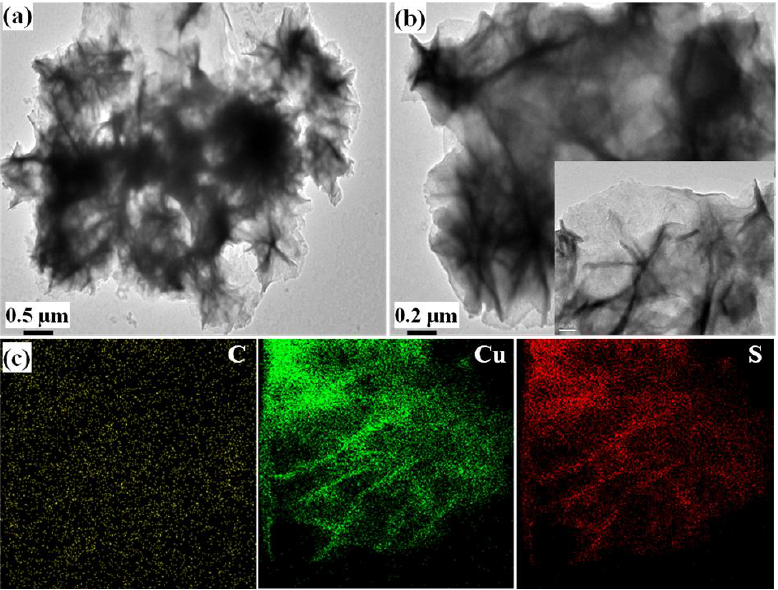
Figure 2. TEM images of ( a , b ) CuS-CNF and their ( c ) corresponding elemental maps.